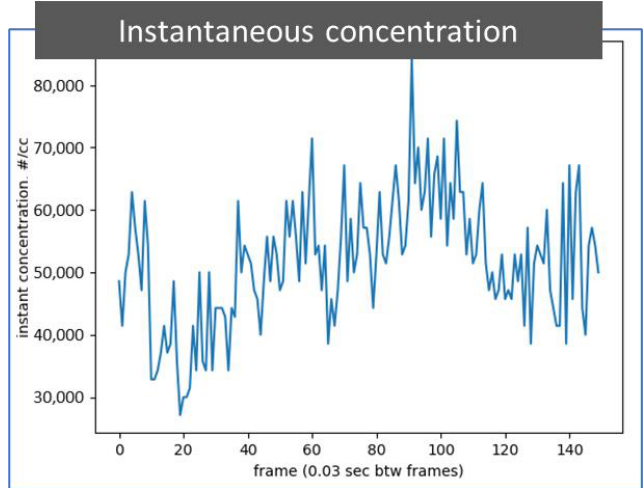
Figure 7. A plot of instantaneous concentration of identified particles. The particle number concen- tration information is extracted through an image process from 150 photos in a 5 s video while de- tecting 50 nm soot particles in the air. The particle detection video is the same as presented in Figure 6b. The time between frames is 0.03 s. The time between frames is 0.03